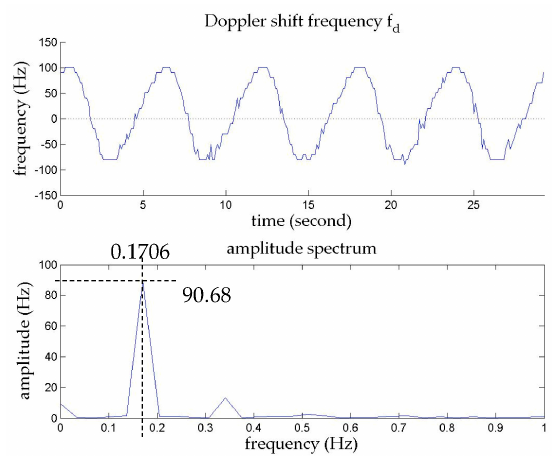
Figure 14. Extracted Doppler shift frequency and its amplitude spectrum. A harmonic of wave frequency can be found at the frequency 0.3412 Hz.